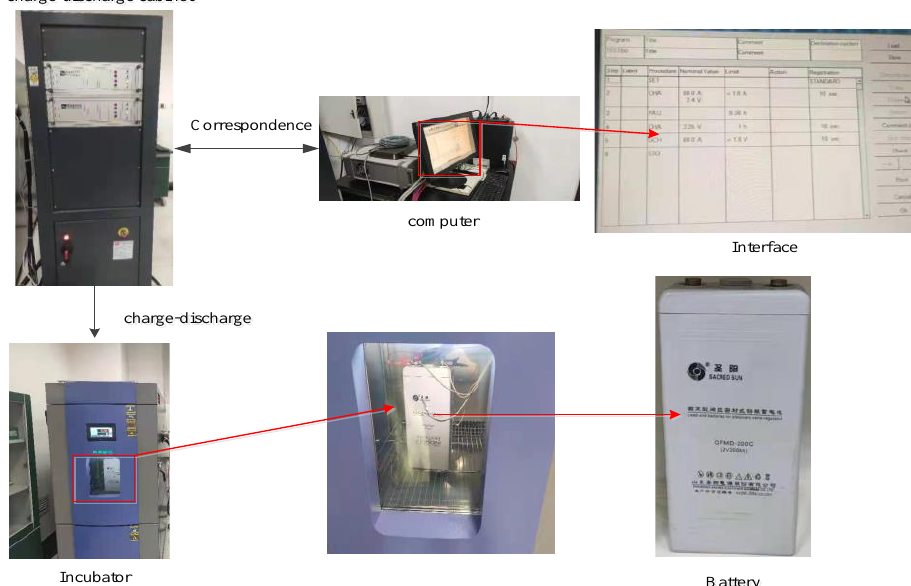
Figure 1. The experimental bench of lead – acid battery.